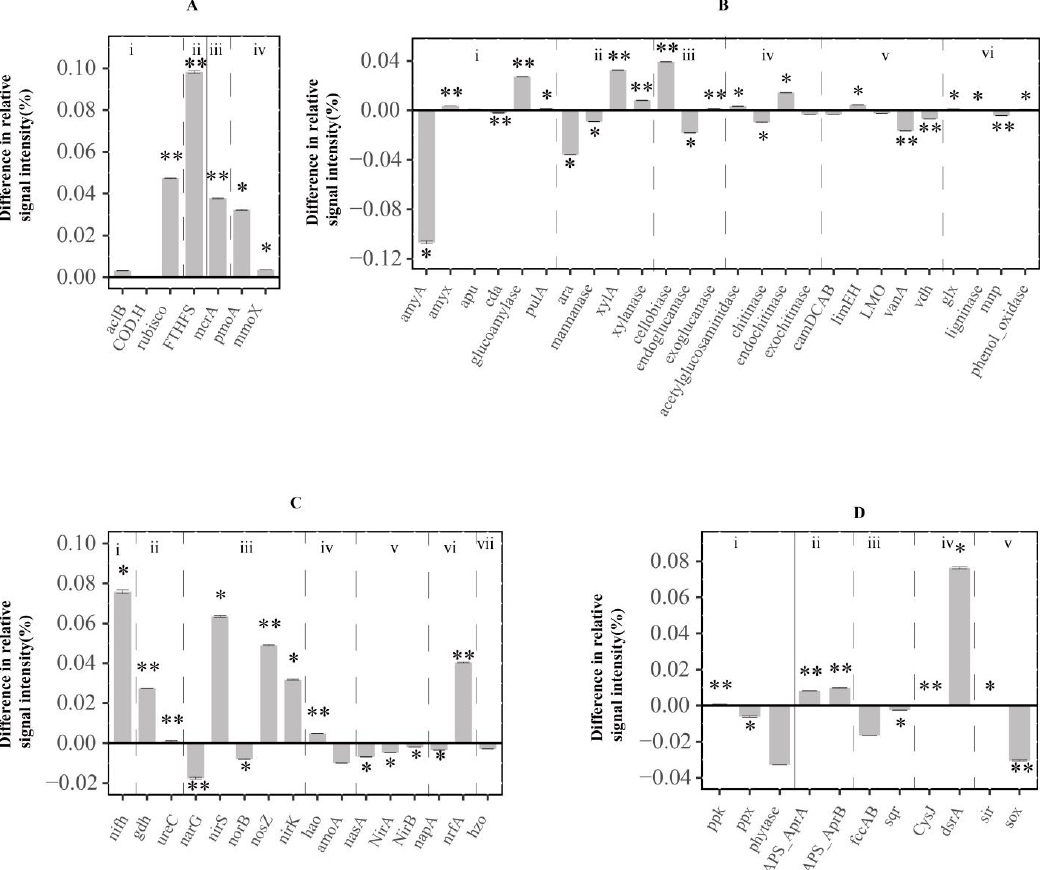
Figure 3. The differences in microbial metabolic potentials between the HL and the RAL based on the relative gene signal intensities. ( A ) Carbon fixation and methane cycling processes. i: